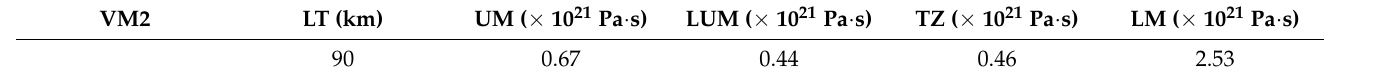
Table 5. Elastic lithosphere thickness and viscosity of the four-layer VM2 profile.